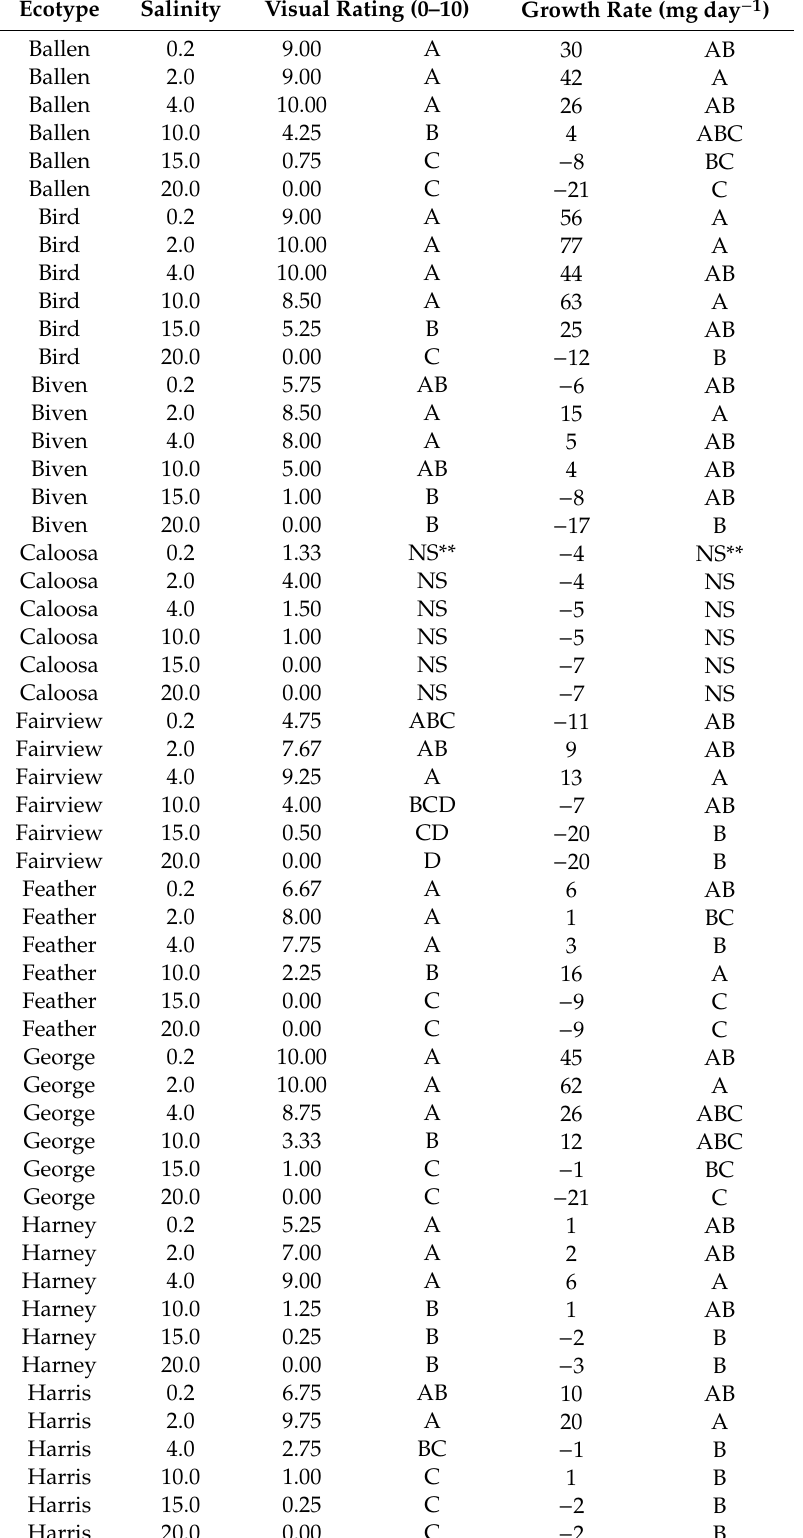
Table A4. E ff ect of salinity on visual rating and growth rate of Vallisneria americana ecotypes. Plants were assigned a visual quality score on a numerical scale of 0 (complete plant death) through 10 (no visible damage). Growth rate was calculated using the Hunt [18]